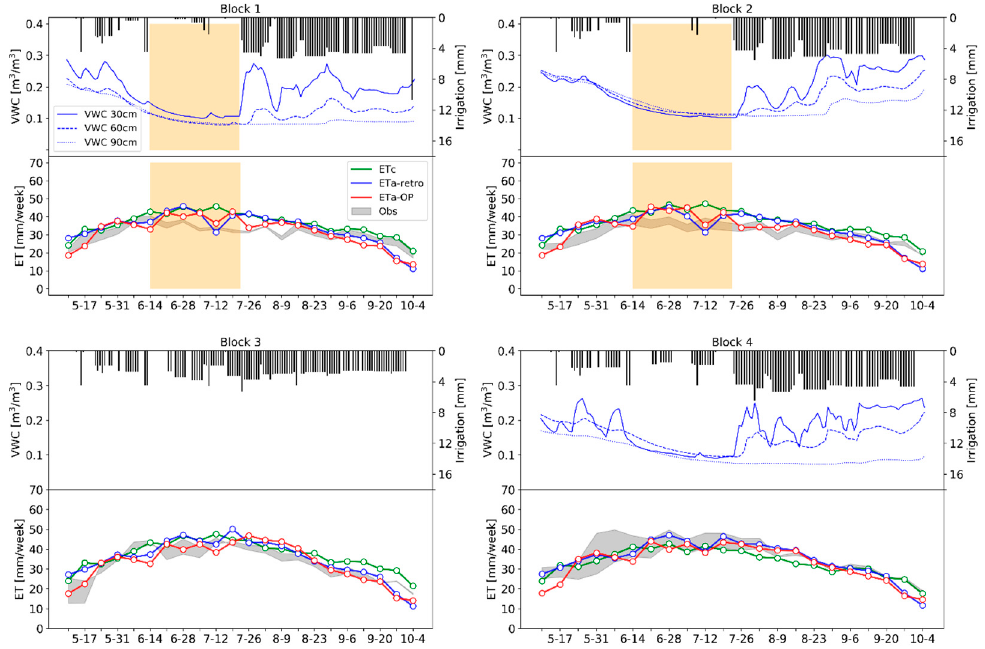
Figure 4. Time series of observed (gray area indicating bounds between closed and unclosed), ET a -OP (red), ET a -retro (blue), and ET c (green) weekly total ET (mm week − 1 ) for blocks 1, 2, 3 and 4 (top to bottom) during the growing season of 2018. Also included is the amount of applied irrigation within each block (black vertical bars) and daily measurements of soil moisture (volumetric water content) at 30 cm, 60 cm and 90 cm depth. Yellow transparent boxes in the top two panels indicate the period of withheld irrigation between 14 June and 23 July 2018.